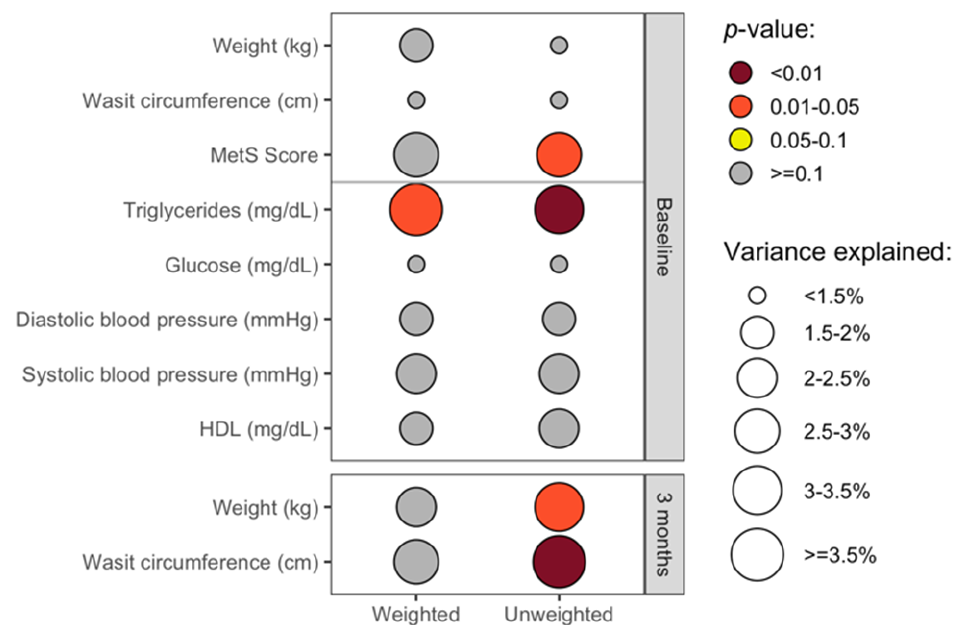
Figure 4. Cross-sectional associations between the gut microbiota and clinical health measures. This plot shows the cross-sectional associations between clinical health measures and the overall gut microbiota composition at baseline (upper panel; n = 56) and three months (lower panel; n = 55) based on permutational ANOVA models, controlling for age and sex, as well as intervention group for analyses of data from three months. The color shows the p-value for the association, and the size of the circles represents the amount of variation explained (R 2 ) in the overall gut microbiota composition as quantified by weighted (left) and unweighted (right) UniFrac metrics. While numerous clinical measures were collected at baseline, including all of the components of MetS, weight and waist circumference were the primary clinical measures collected at three